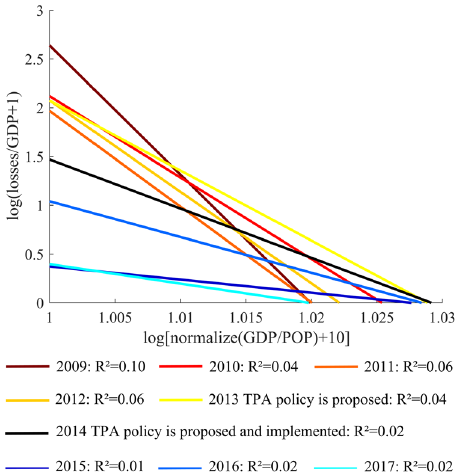
Fig. 3 Power-law relationships between geological disaster economic losses and economic development in different years in Yunnan Province, China. The negative relations shown in this fi gure imply that poor counties suffered greater direct economic losses from geological disasters than more wealthy ones. A counterclockwise rotational displacement of trend lines is also